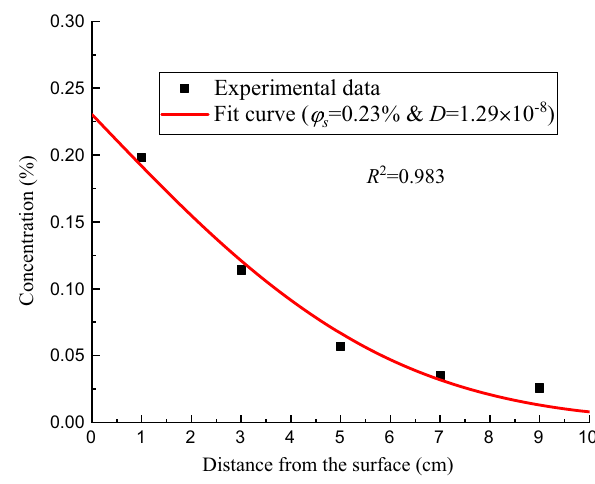
Fig. 5 Determination of surface concentration and diffusion